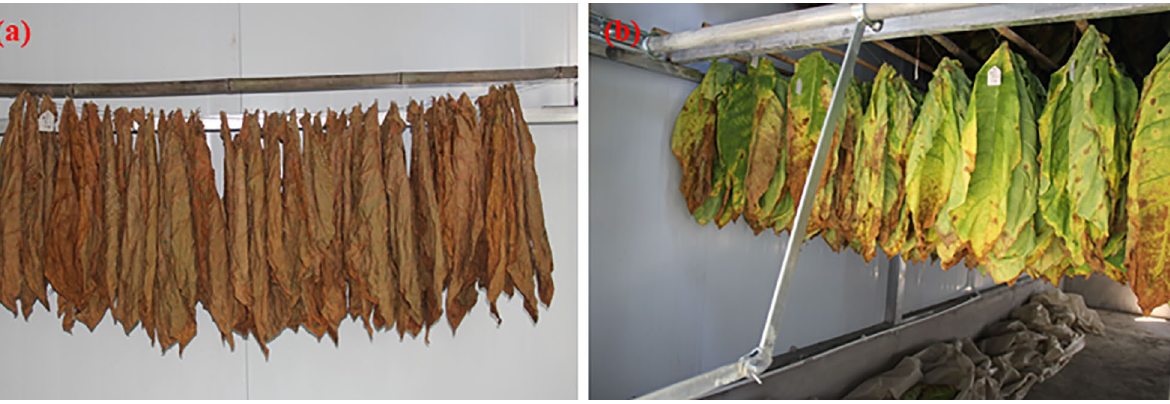
Figure 8. The distribution of tobacco leaves during